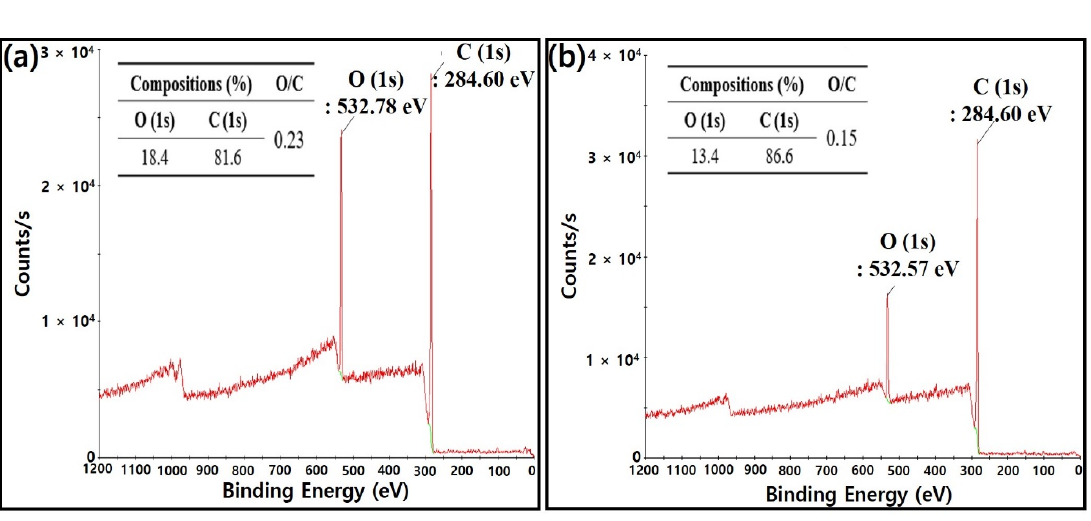
Figure 10. X-ray photoelectron spectroscopy (XPS) spectra and compositions of ( a ) native c-NFs and ( b ) plasma-treated c-NFs.